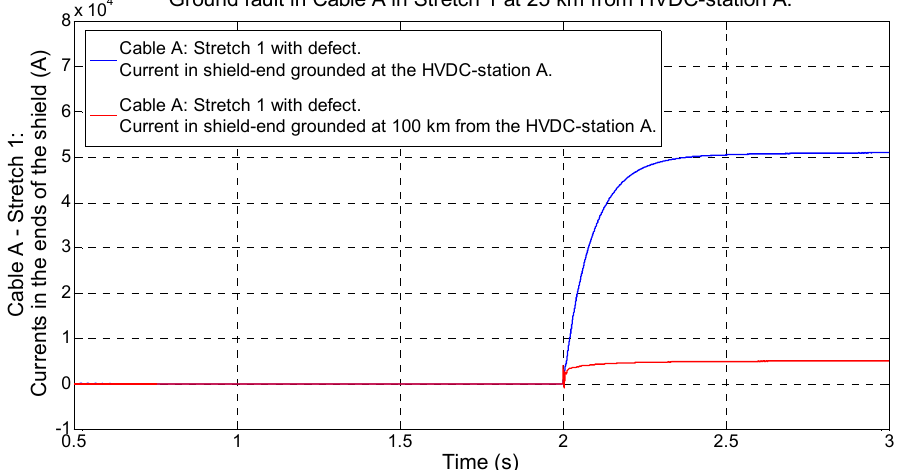
Figure 10. Circulation of ground fault currents in the ends of the shield in Stretch 1 of Cable A in case of internal ground fault.